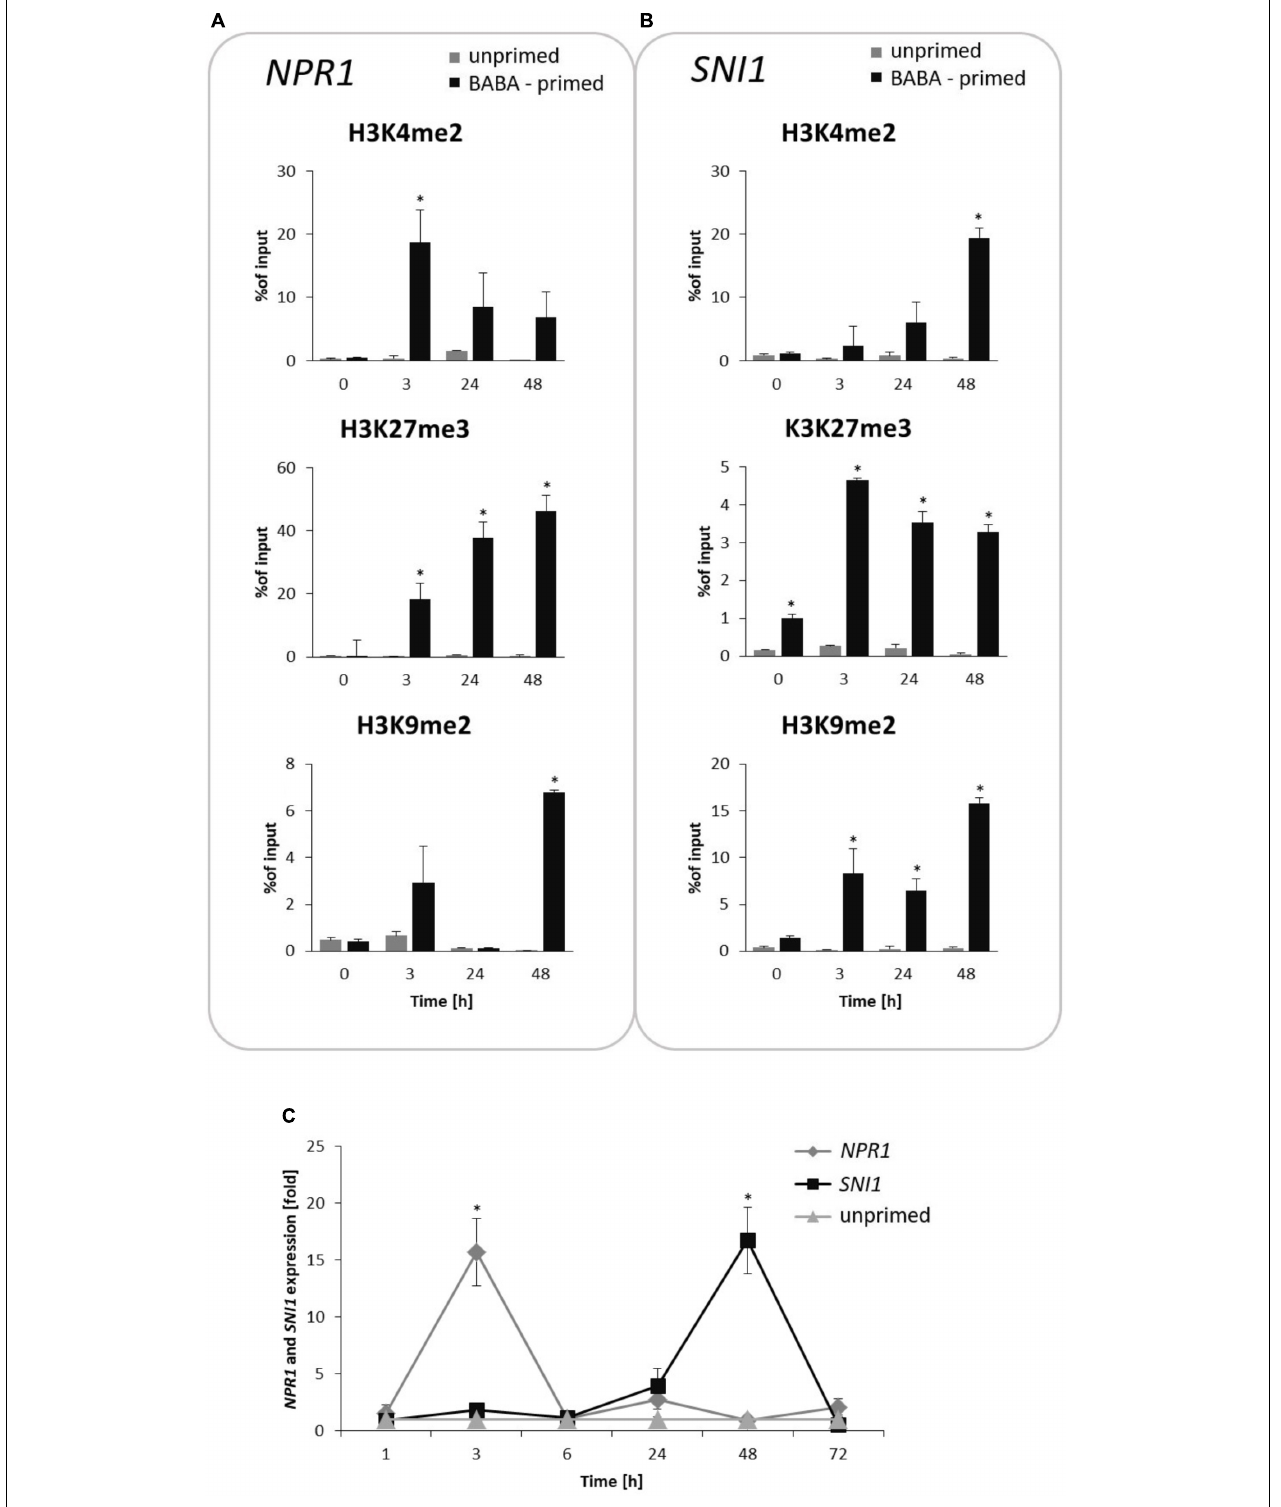
FIGURE 6 | Switchable deposition of chromatin marks on the NPR1 and SNI1 gene, in which transcription antagonized silencing. Time-dependent H3 methylation profiles on NPR1 (A) and SNI1 (B) and their transcript levels (C) in the prime state before the triggering stress. ChIP-qPCR and RT-qPCR analysis of NPR1 and SNI1 gene expression were performed at 3, 24, 48, and 72 h after 5 mM BABA treatment. Each experiment was repeated three times and the data are presented as percentages of input DNA. Asterisks indicate values that differ significantly from unprimed (water treated) potato leaves at P < 0.05 ( ∗ ).